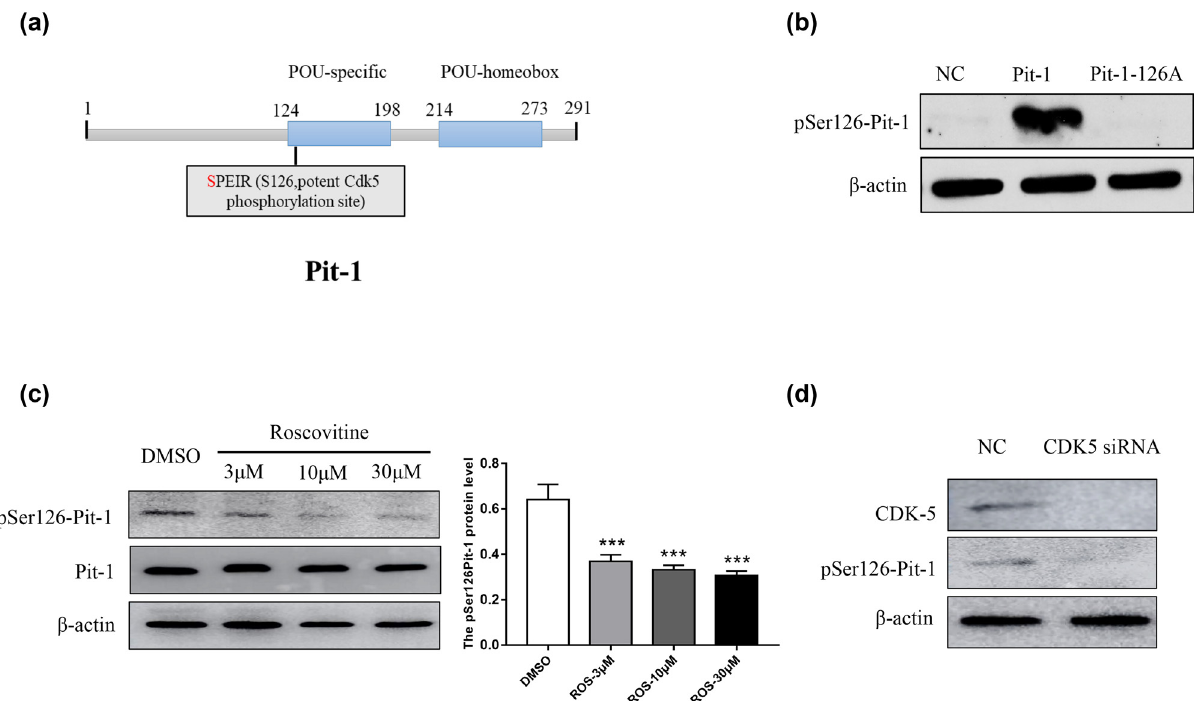
Figure 1: Both CDK5 inhibition and depletion a ff ect the phosphorylation level of Ser126 - Pit - 1. ( a ) Bioinformatics analysis reveals that Ser126 Pit - 1 was the only typical CDK5 potential phosphorylation site. ( b ) GH3 pituitary cells were transfected with WT - Pit - 1 or Pit - 1 - 126A. Western blotting shows that the anti - pS126 - Pit - 1 antibody can speci fi cally recognize the phosphorylation of Ser126 - Pit - 1. ( c ) . Western blot ( left ) and densitometry analysis ( right ) showed that S126 - Pit - 1 phosphorylation was reduced by roscovitine treatment at the indicated concentra - tions. The protein levels of Pit - 1 was not clearly di ff erent. β - Actin served as a loading control. ( d ) Western blot showed that Ser126 - Pit - 1 phosphorylation was reduced by CDK5 siRNA treatment at the indicated concentrations. β - Actin served as a loading control. **, P < 0.01; ***, P < 0.001. The bar represents the mean ±